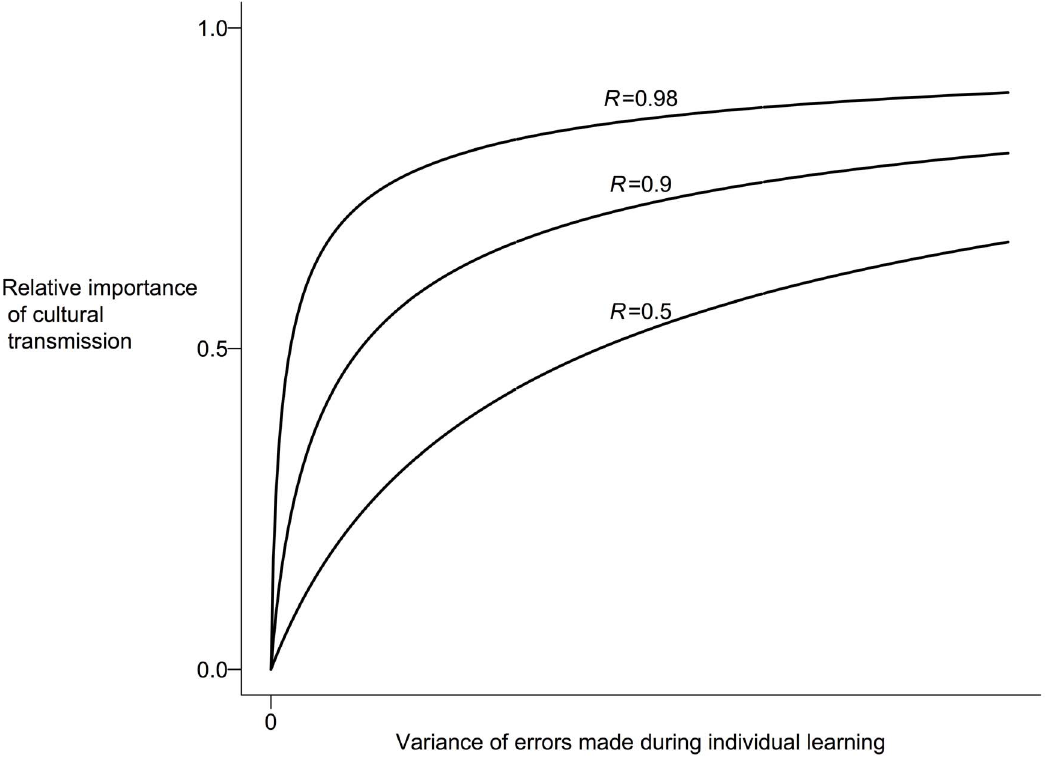
Figure 1. When culture (tradition) is favored in a fluctuating environment. A result of an evolutionary model of learning ([13], chap. 4), plotted are three curves for three values of environmental autocorrelation ( R ). Higher values of R indicate more similar environments through time. This result extends to Bayesian learners and environmental heterogeneity [17]. Social learning (e.g. imitation or adherence to tradition) is favored by natural selection and will maximize utility as environments change less and individual learning becomes more error